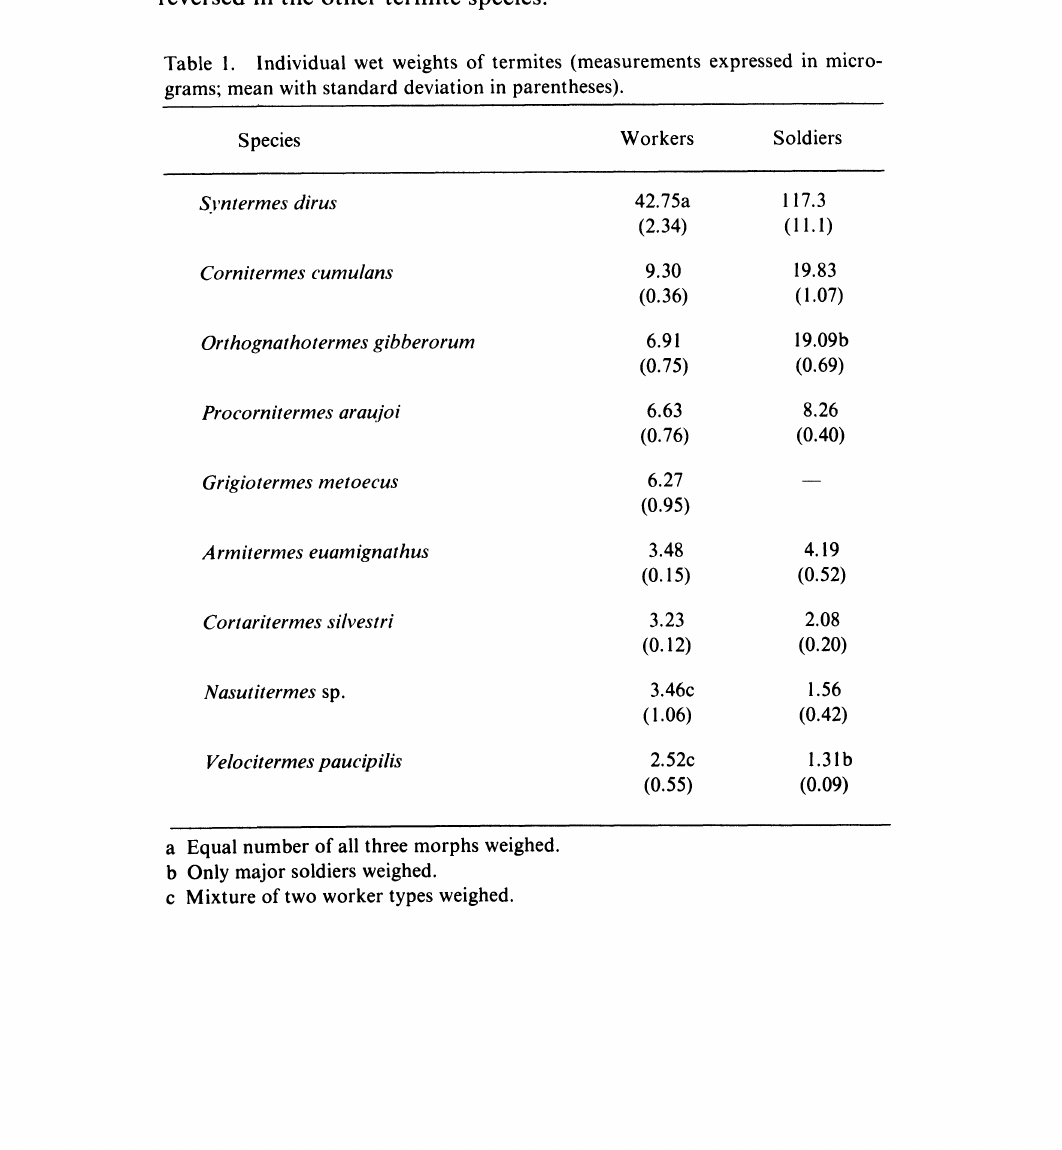
Table 1. Individual wet weights of termites (measurements expressed in micro- grams; mean with standard deviation in